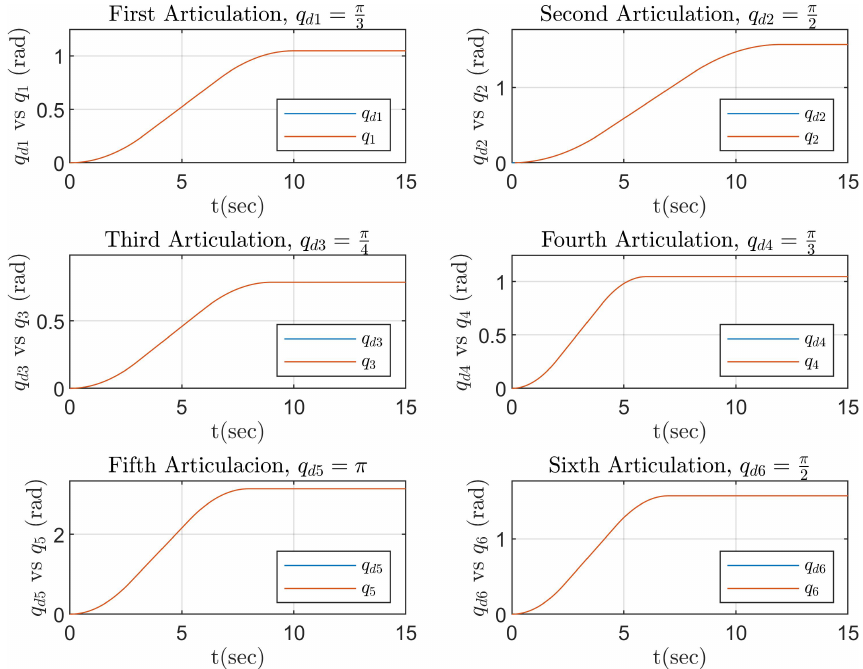
Figure 12. Trajectory tracking simulation of the applied SMC.